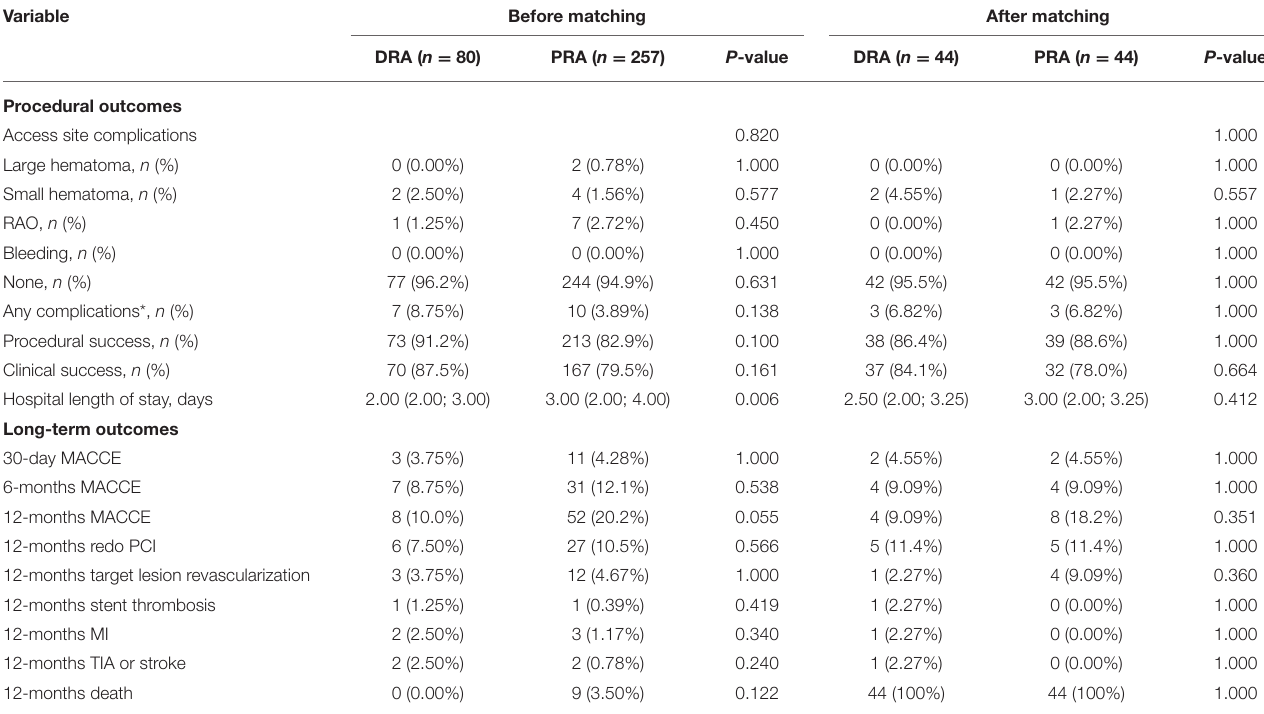
TABLE 3 | Procedural and long-term outcomes. Variable